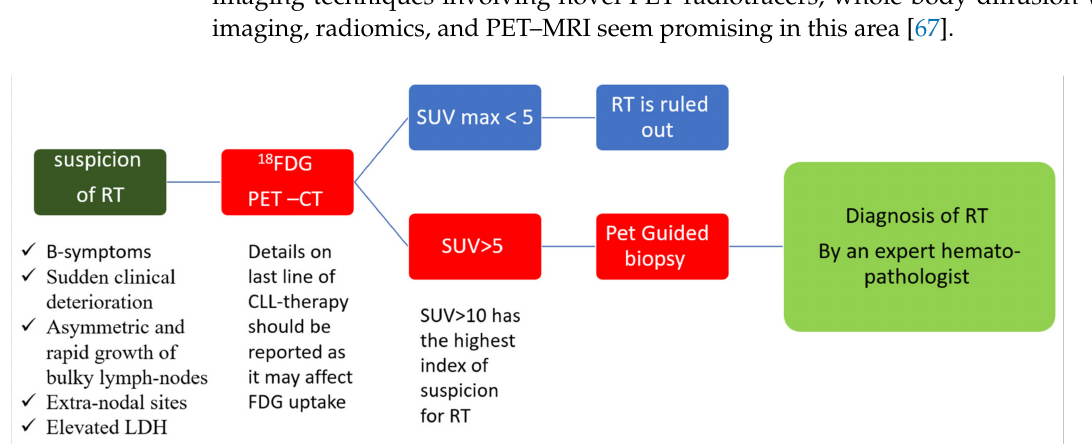
Figure 2. Diagnosis of Richter transformation. Legend: 18-FDG-PET–CT: positron emission tomography with 2-deoxy- fluorine-18-fluoro-D-glucose; CLL: chronic lymphocytic leukemia; LDH: lactate dehydrogenase; RT: Richter transformation; SUV: standardized uptake values.